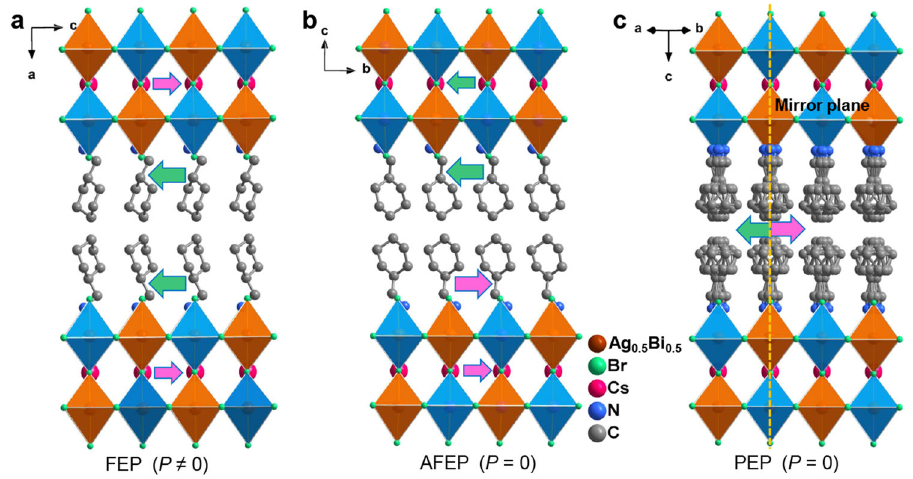
Fig.2|Crystalstructuresof1. Diagramofcrystalstructurepackingsinthe a FEPat 300K, b AFEP at 360K and c paraelectric HTP at 390K. The atoms with the probability of Ag and Bi of 50% are shown in brown. Hydrogen atoms are omitted